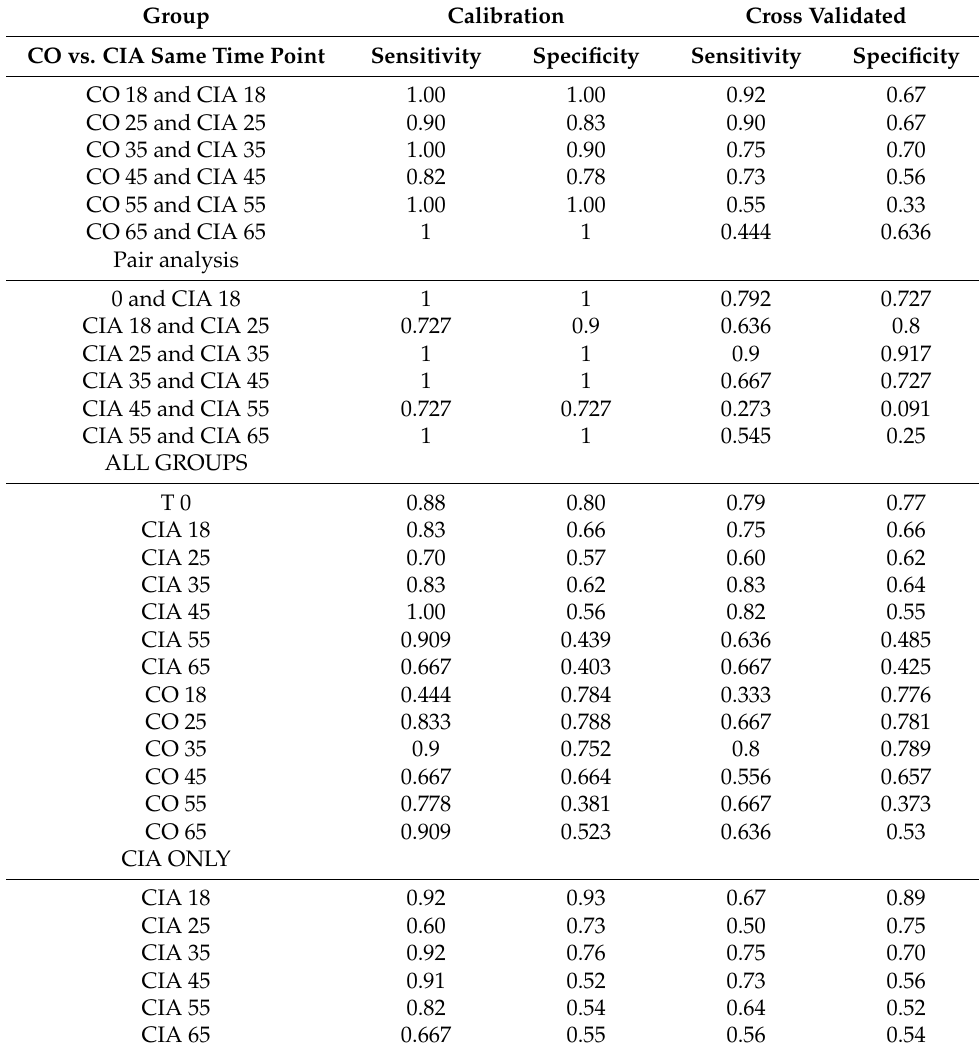
Table 1. Specificity and sensibility of NMR data after PLSDA model built obtained by the venetian blind